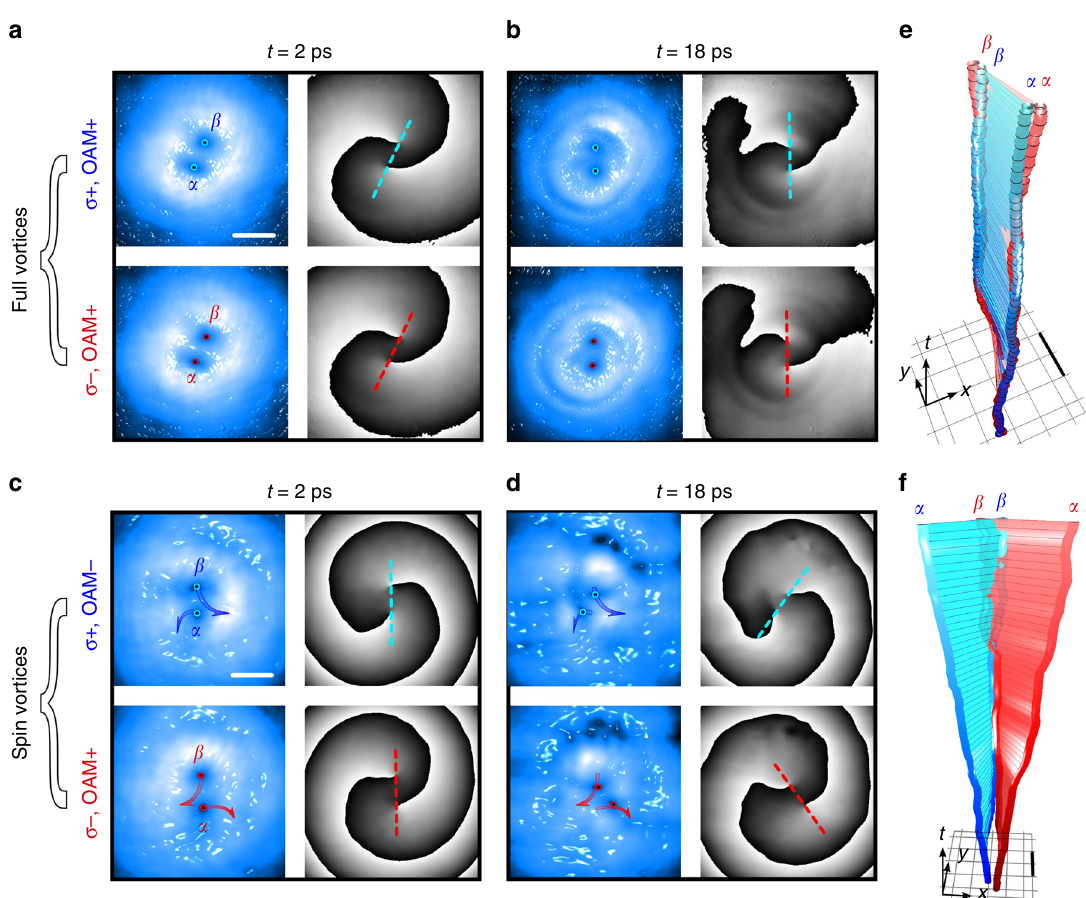
Fig. 4 Nonlinear rotation of spinorial vortex pair con fi gurations. a , b Amplitude and phase maps of the polariton fl uid, when starting with two full vortices (same OAM in the two opposite-spin populations), at initial and later time frames. c , d Initialization with two spin vortices (opposite OAM between the two spin populations), amplitude and phase maps of the polariton fl uid at different time frames. Movements of the phase singularities are tracked as blue and red dots in the amplitude maps, while the solid arrows in c , d represent the two vortex trajectories during the whole dynamics ( Δ t = 0 – 35 ps). The initial total population is P = 450 × 10 3 (i.e., intermediate between the P 3 and P 4 cases of Fig. 1). e , f Vortex ( x , y , t ) trajectories for ( e , Δ t = − 4 – 50 ps) cowinding and ( f , Δ t = 0 – 31 ps) counterwinding cases. The scale bars are 25 μ m in the space maps ( a , c ) and 10 μ m in the ( x , y , t ) plots ( e , f ). The color code of labels, arrows and vortex tubes indicates the right (blue, σ + ) and left (red, σ − ) spin components. The dashed lines in the phase maps help highlight the opposite rotations of the vortex pairs depending on their OAM direction. Please note that the amplitude and phase maps at t = 2 ps ( a , c ) represent both the photonic pump pro fi les (for the two spinorial con fi gurations) and the initial condition of the polariton fl